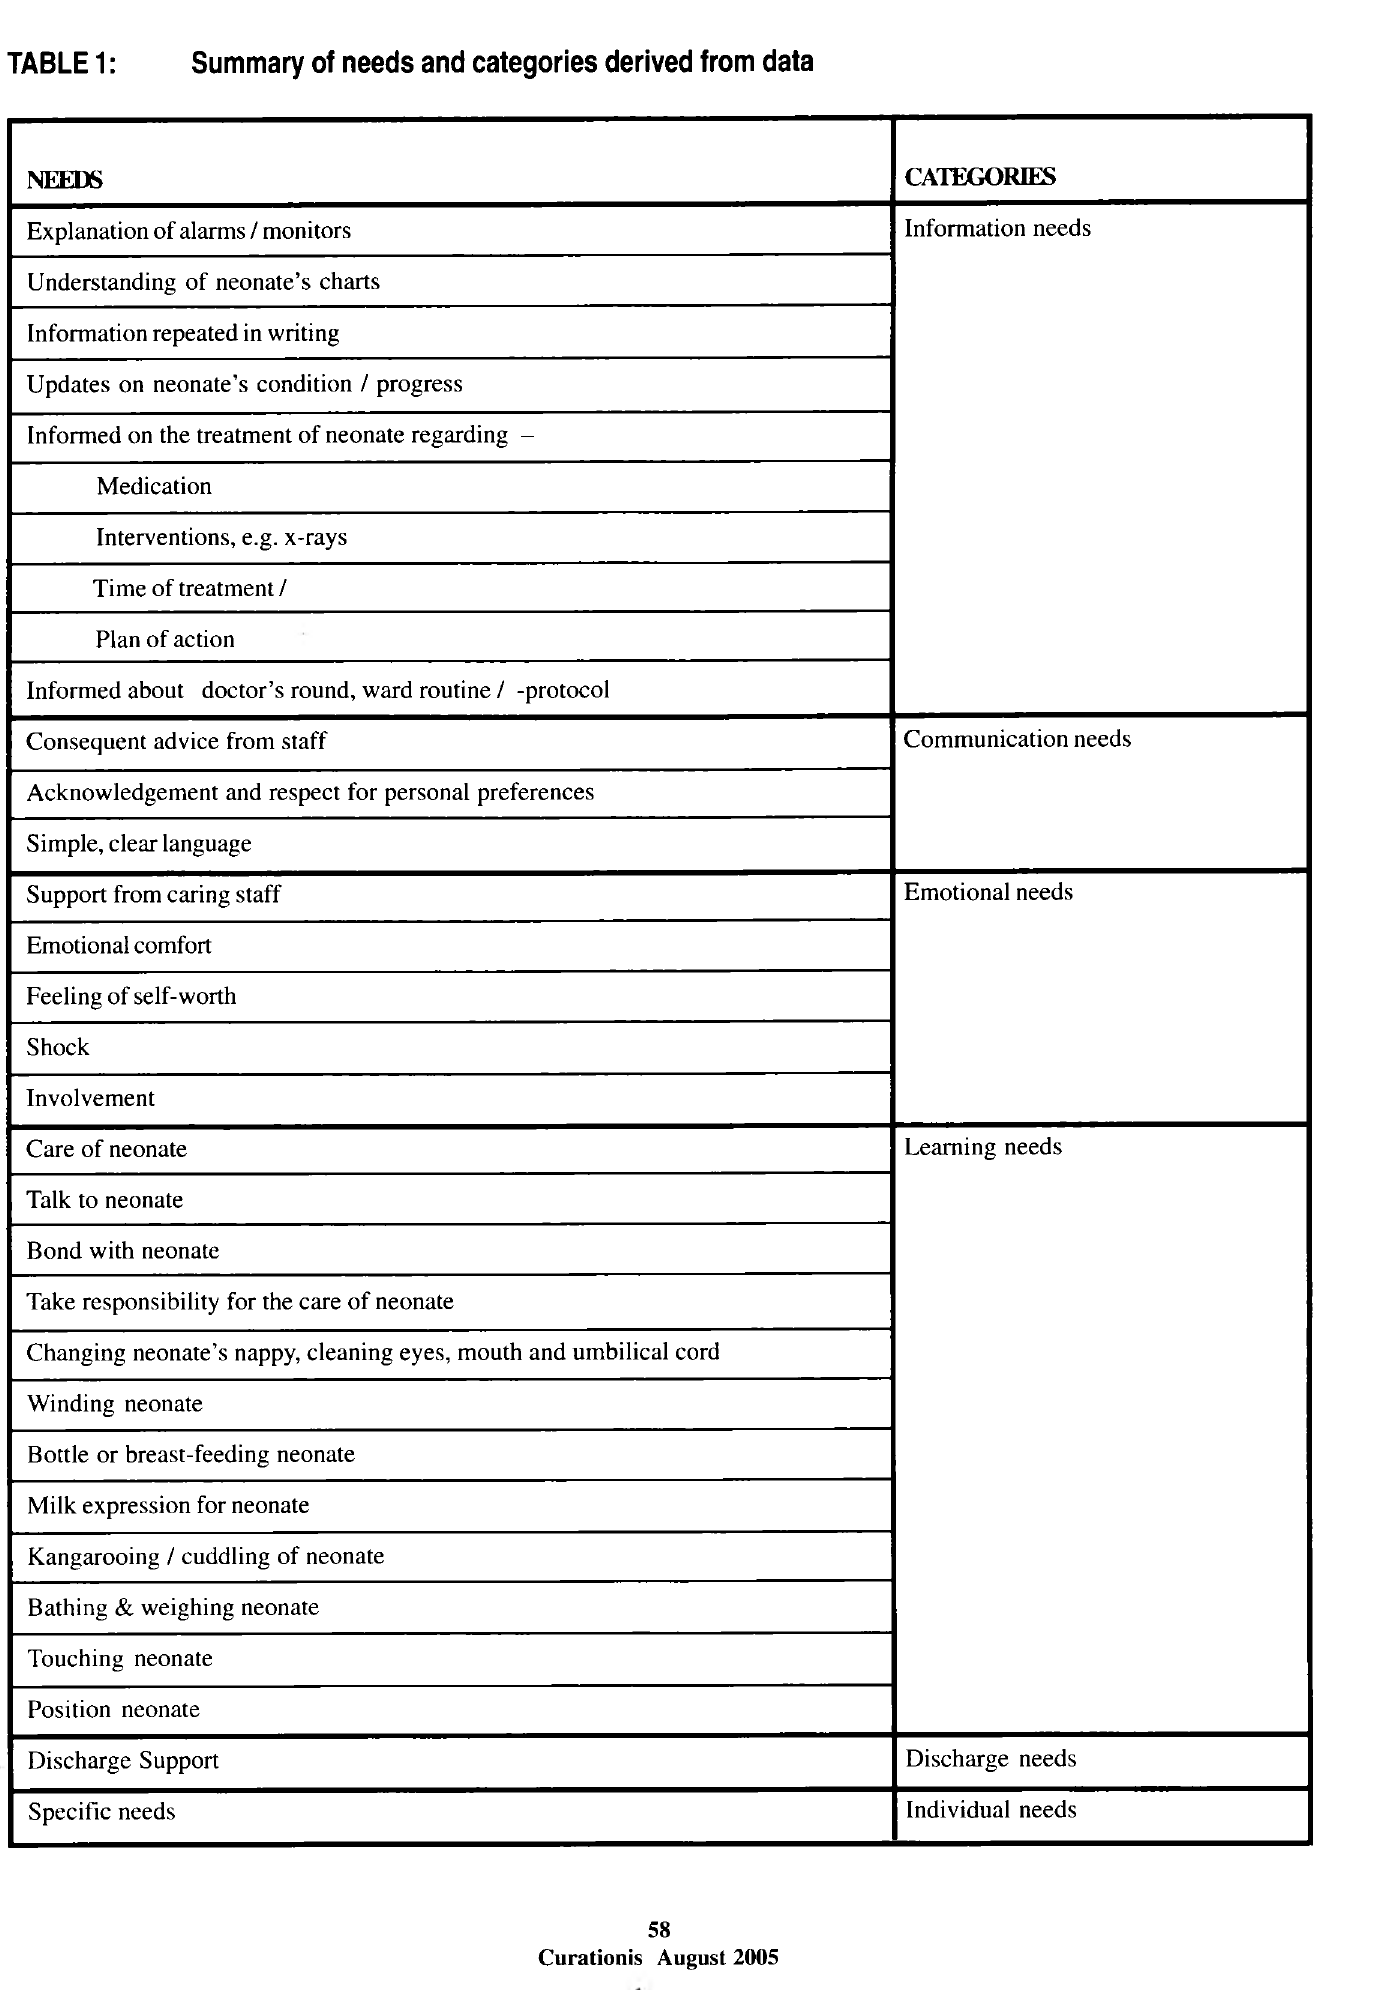
TABLE 1: Summary of needs and categories derived from data